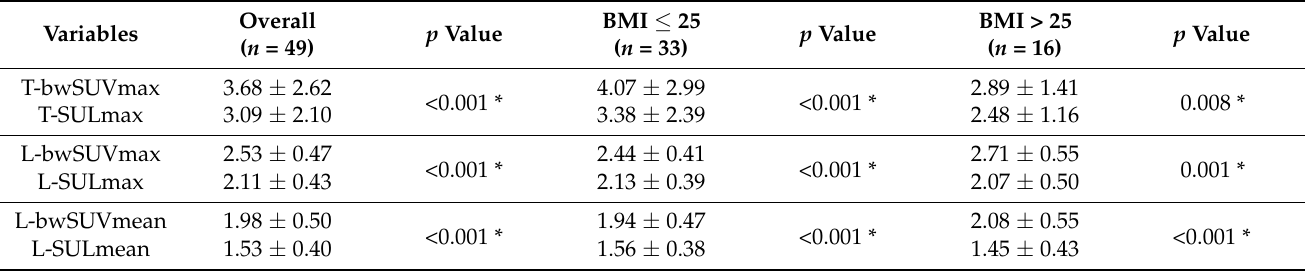
Table 2. Comparison of metabolic parameters according to body mass index.